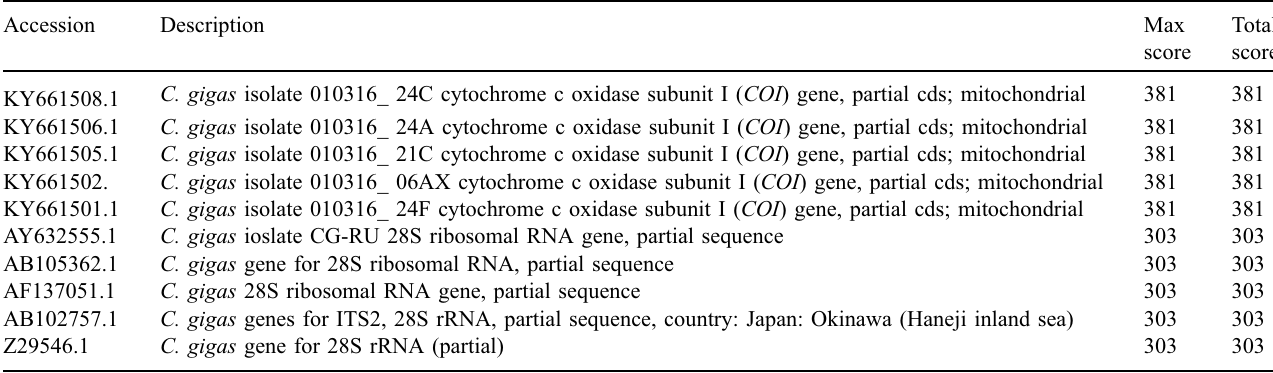
Fig. 3. Gel electrophoreses of PCR products and the gray values from COI and 28S rRNA DNA ampli fi cation using the OSE (O) and GLB (G) extraction methods. (A) Electrophoretic map of the COI target fragment, lanes 1 – 3 were shell DNAs extracted by improved OSE, and lanes 4 – 6 were shell DNAs extracted by GLB; (B) electrophoretic map of the 28S rRNA target fragment, lanes 1 – 3 were shell DNAs extracted by improved OSE, and lanes 4 – 6 were shell DNA extracted by GLB; (C) gray values of the target fragment of COI ; and (D) gray values of the target fragment of 28S rRNA. Each bar represents the mean ±SD ( n =3). ** P < Table 2. Comparison of targeted DNA sequences from C. gigas shells.